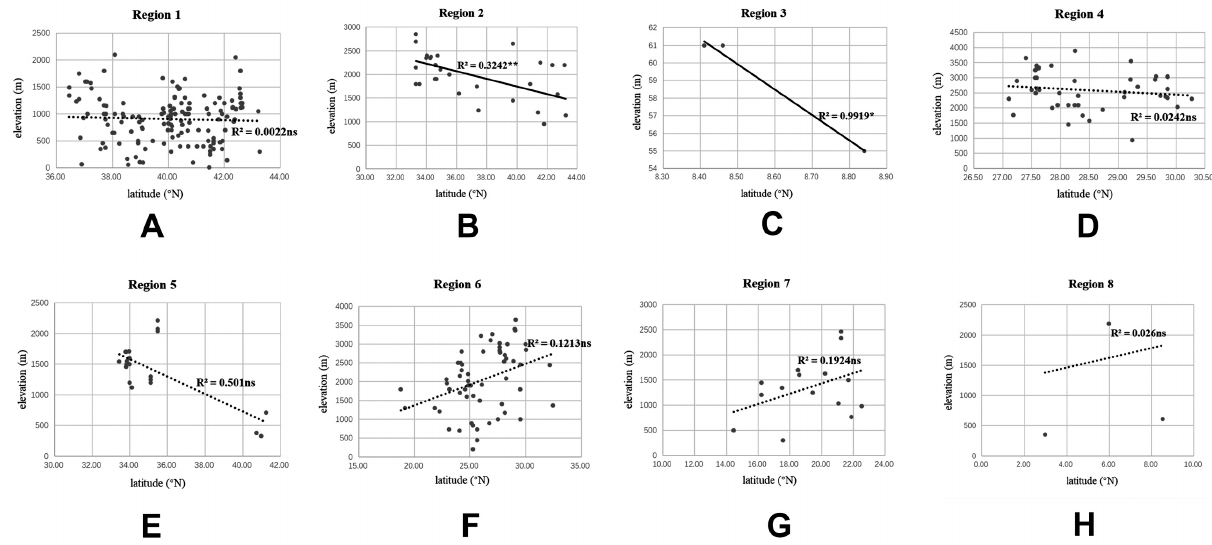
Figure 27. Correlation between elevation and latitude in each region, ( A ) Europe, North Africa and West Asia (Region 1); ( B ) Central Asia (Region 2); ( C ) south part of South Asia (Region 3); ( D ) southern Tibet and adjacent area (Region 4); ( E ) Palearctic part of East Asia (Region 5); ( F ) Oriental China (Region 6); ( G ) Indochina Peninsula (Region 7); ( H ) Indo-Malaysia (Region 8). Significance levels: **, p < 0.01; *, p < 0.05. ns = not significant.